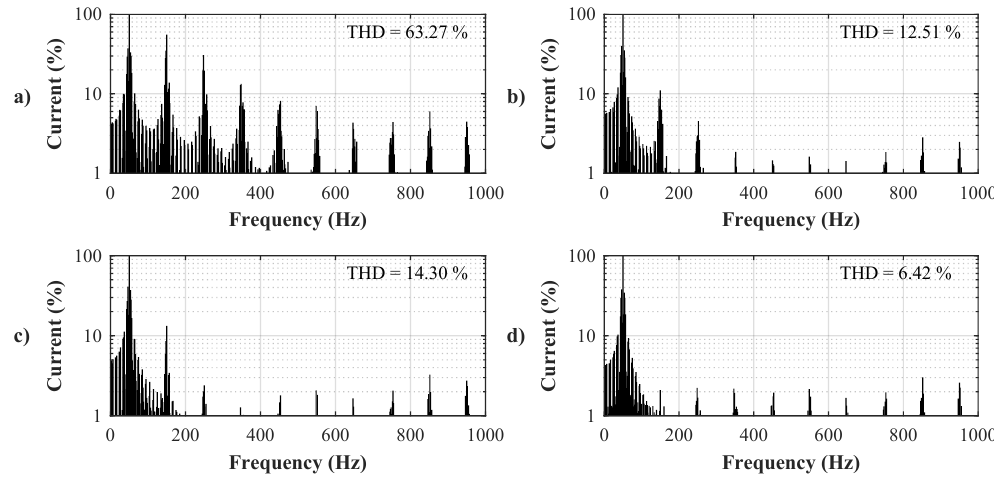
Figure 14. FFT of input signal from 0 to 600 ms; ( a ) before filtration, ( b ) after applying the LMS algorithm with a filter length of 10 and a step size of 0.005, ( c ) after applying the NLMS algorithm with a filter length of 100 and a step size of 0.005, ( d ) after applying the RLS algorithm with a filter length of 2 and a forgetting factor of 0.999.